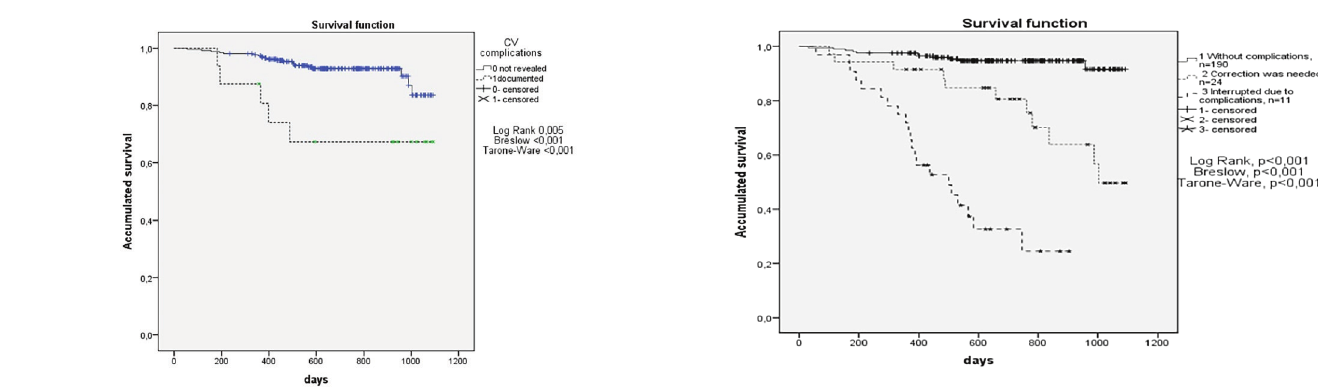
Figure 3 - Kaplan-Meier survival curves for the presence (absence) of CV complications.